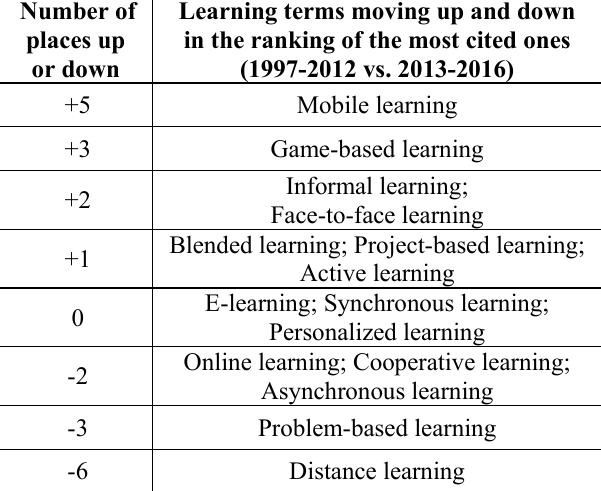
Table 2. Learning terms moving up and down in the ranking of the most cited